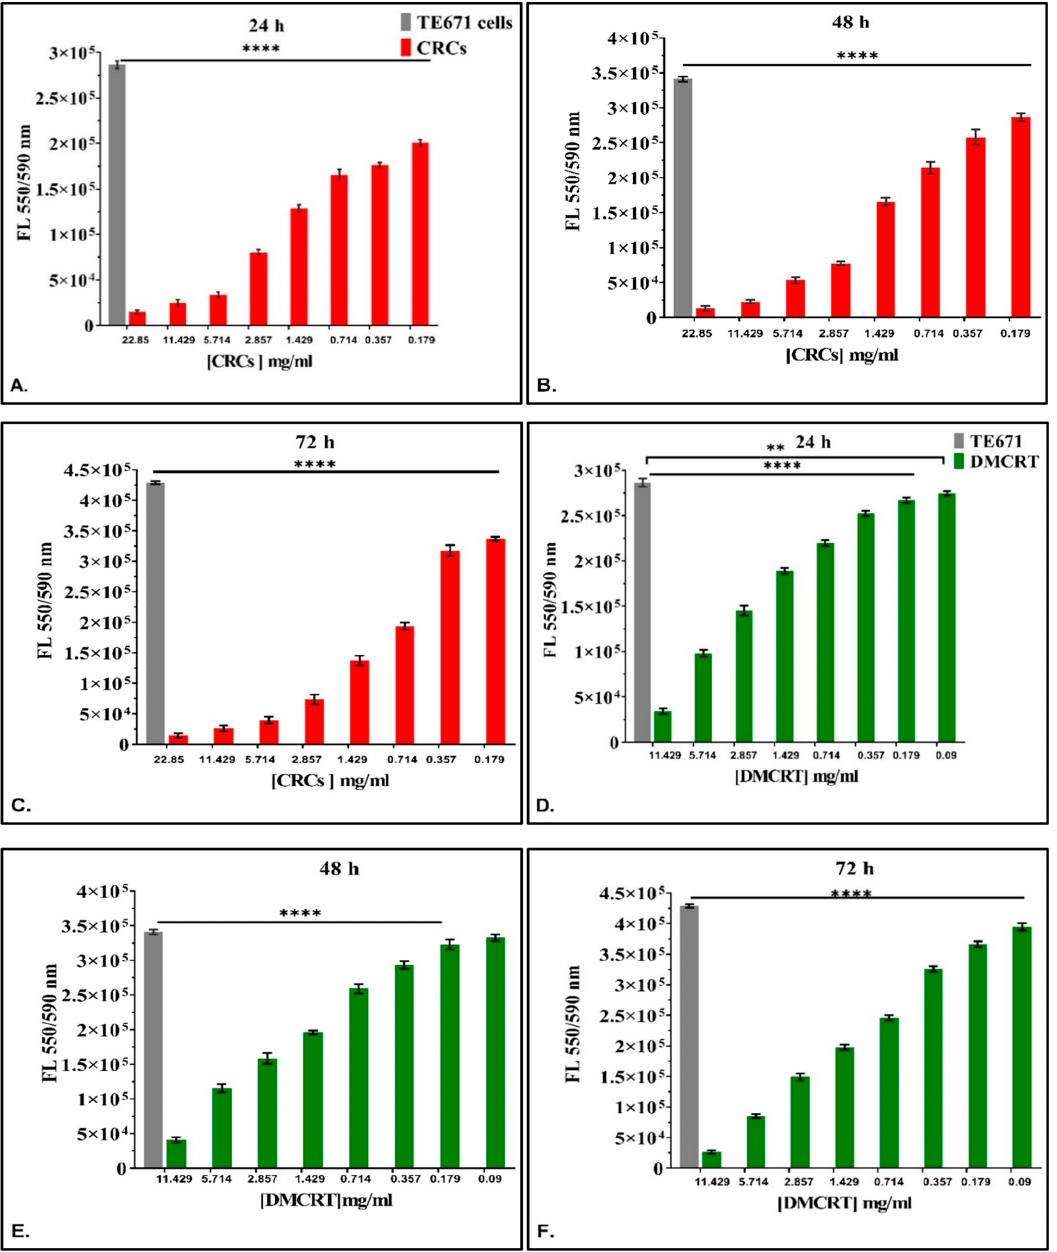
Figure 7. Dose-dependent effect of CRCs and DMCRT on TE671 cells. CRCs exerted a significant dose-dependent effect at all time intervals ( p < 0.005 for cells exposed to any concentration of CRCs vs untreated TE671) ( A – C ). Similarly, DMCRT was also effective, manifesting significant increasing cytotoxicity, with increasing concentrations ( D – F ). Legend : CRCs : Crocins, DMCRT : dimethylocro- cetin, FL : Fluorescence Intensity. Asterisks (*) depict at least p < 0.05 significance level between control experiments and CRCs (** p < 0.01; **** p < 0.0001). Each value represents the mean ± S.D. of triplicate experiments